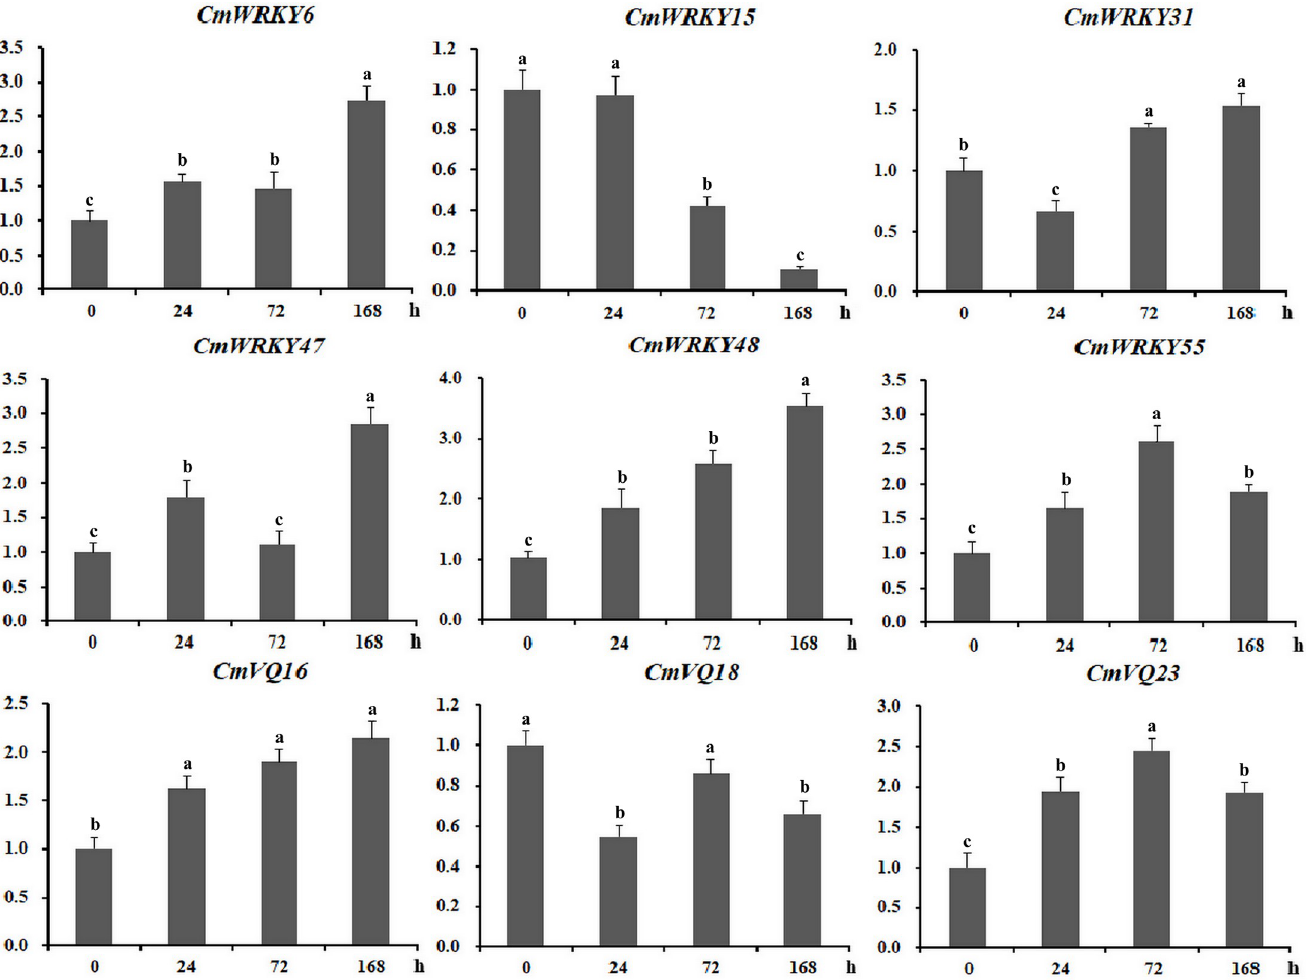
Fig 8. qRT-PCR validation of the differential expression of 9 genes involved in resisting to powdery mildew infection. CmActin was used as the internal control. The Y-axis indicates the relative expression level; X-axis (0, 24, 72, 168 h) indicated hours after powdery mildew fungus infection. Error bars indicate the SD of three biological